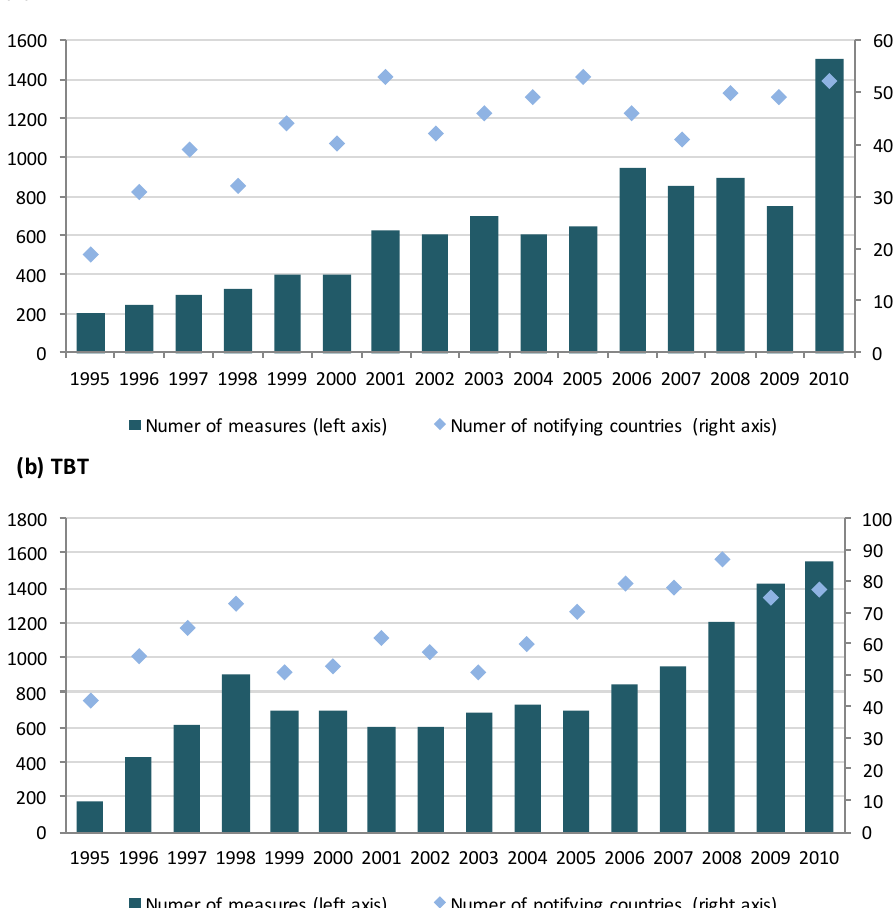
Figure 1. SPS and TBT notifications 1995-2010 (# of notifying countries and